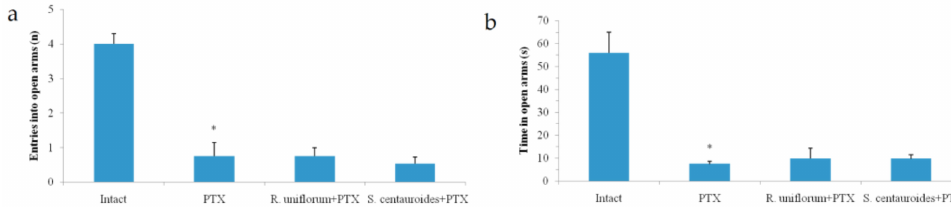
Figure 4. Entries into open arms ( a ) and time in open arms ( b ) in elevated plus maze test after R. uniflorum and S. centauroides extracts application against picrotoxin (PTX) introduction. Data represent as mean ± S.E.M. *— p < 0.05 vs. intact group.